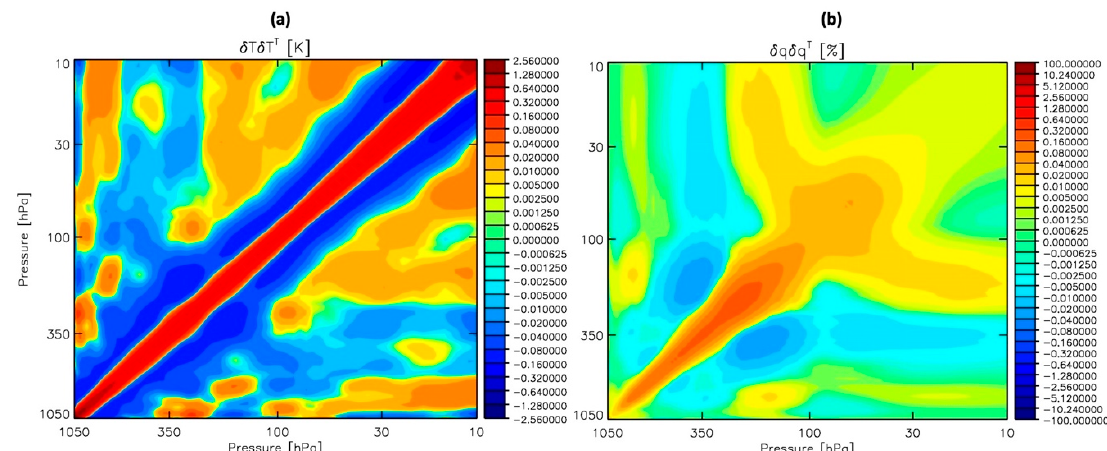
Figure 3. A priori error covariance matrix for ( a ) temperature [Kelvin] and ( b ) water vapor [%]. The temperature error covariance matrix, δ T δ T T , is calculated from an ensemble of profile di ff erence between ECMWF and Merra2, and the water vapor error covariance matrix, δ q δ q T , is calculated in the same way except in percentage units ([ECMWF–Merra2] / ECMWF). The ensemble is made up of 233,135 profiles from four focus days to cover four seasons; 1 January 2015, 1 April 2015, 1 July 2015 and 1 October 2015